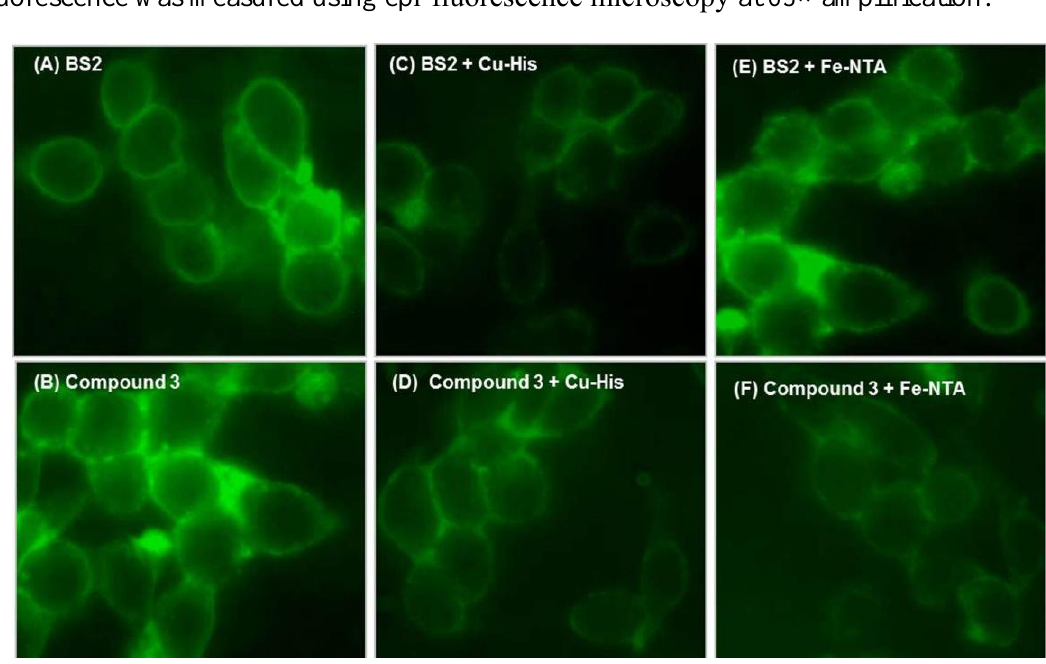
Figure 8. SH-SY5Y cells were washed and treated with compound BS2 or 3 and the basal fluorescence was measured: ( A ) and ( B ), respectively. The cells were incubated with Cu-His (200 μM, 15 min) and their fluorescence determined ( C ) and ( D ). The cells were incubated with Fe-NTA (80 μM, 12 h) and their fluorescence determined ( E ) and ( F ). The fluorescence was measured using epi-fluorescence microscop at 63×